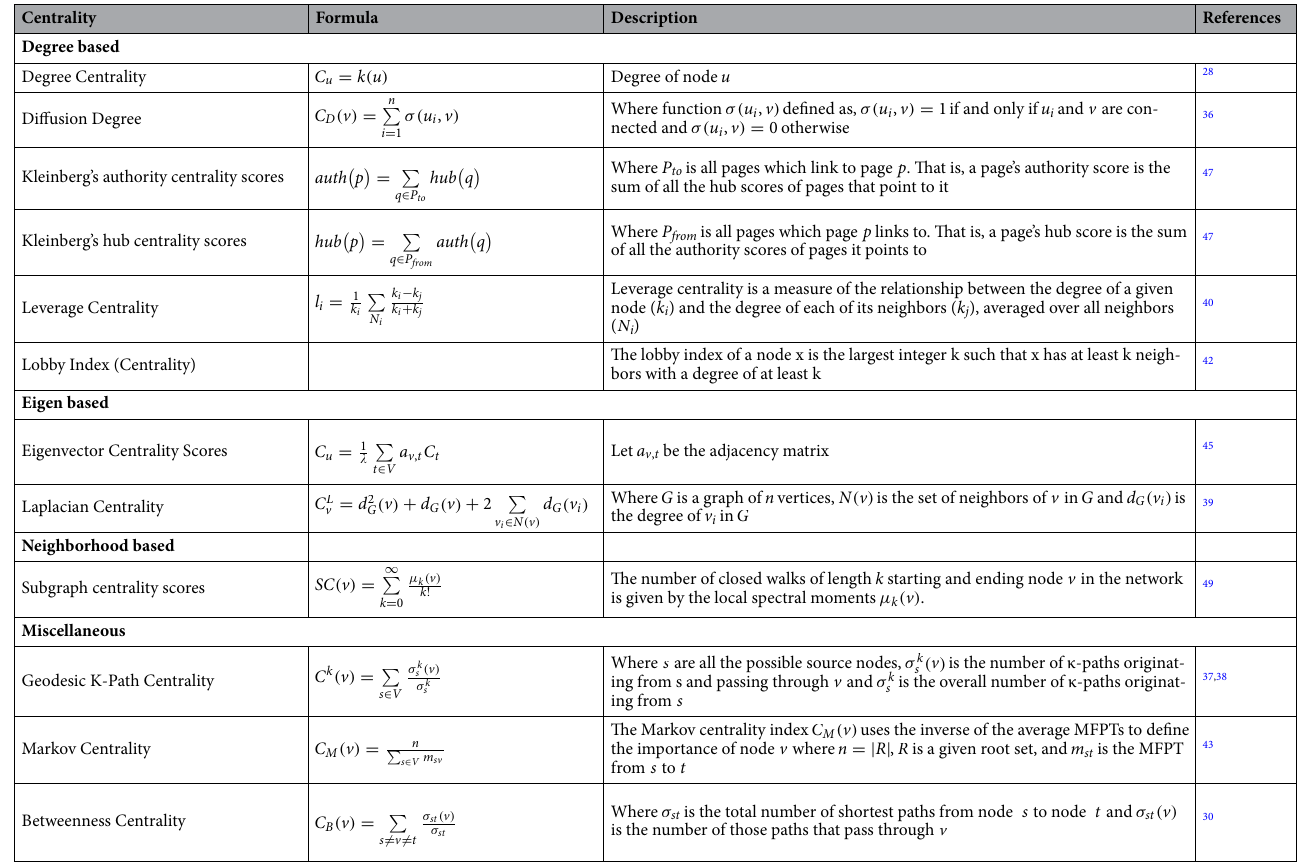
Table 3. Definitions for Degree based, Eigen based, Neighborhood based, and Miscellaneous centrality measures.